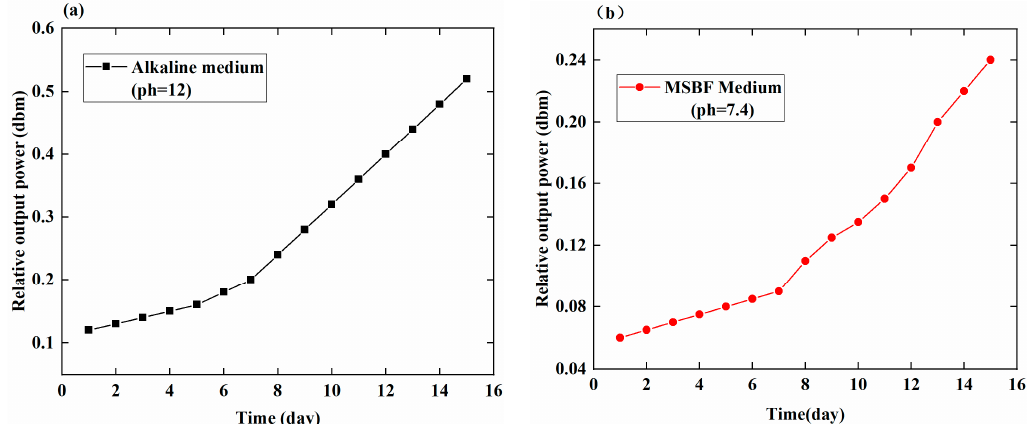
Figure 4. Relationship between relative output power (dbm) and time (days) using the MB sensor to assess the degradation state of the EMBAB in different media. ( a ) Relative output power of EMBAB in the alkaline medium over 15 days. ( b ) Relative output power of EMBAB in the MSBF medium over 15 days.